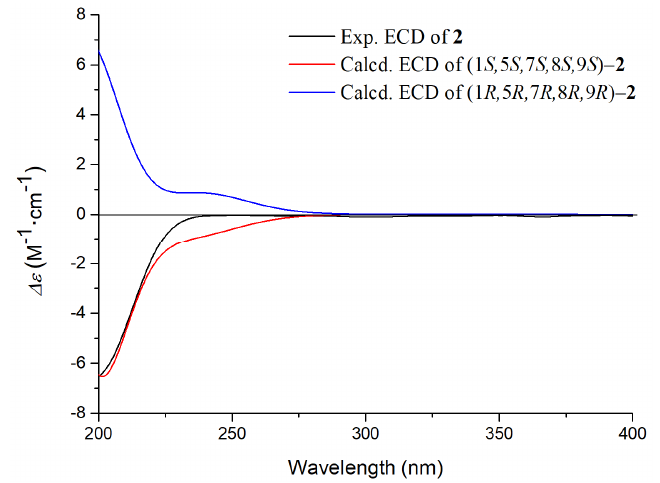
Figure 4. Calculated and experimental ECD for compound 2 .